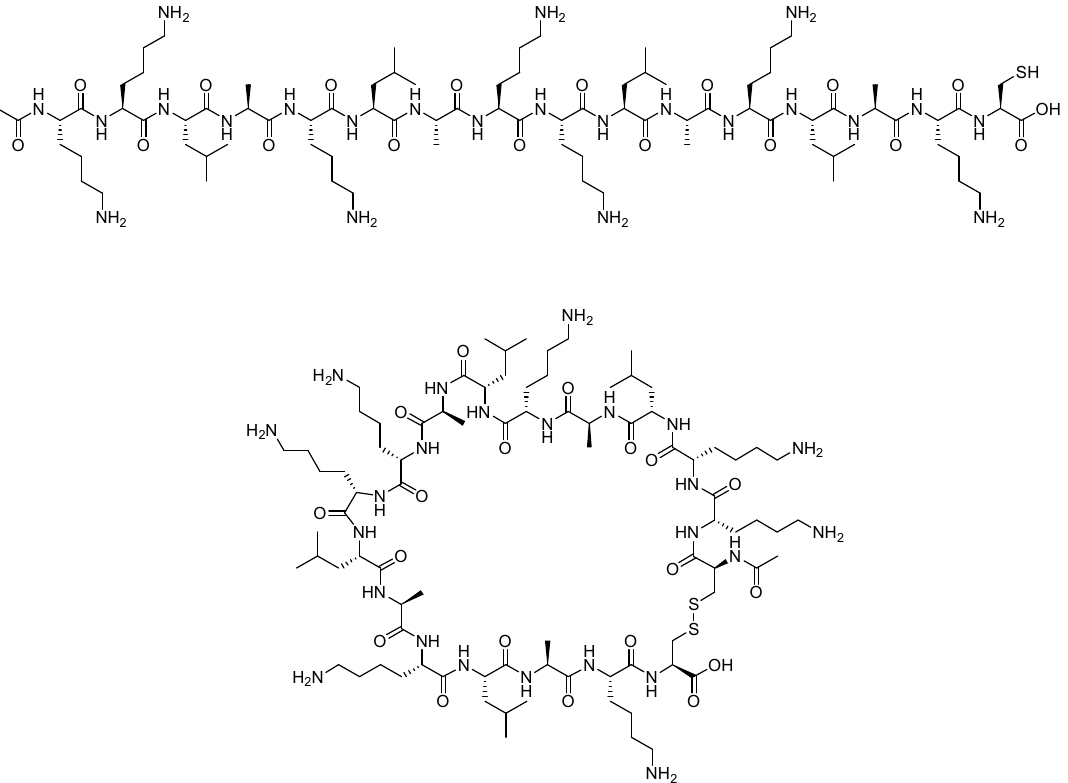
Figure 13. Chemical structure of ( A ) Linear KLA-SS peptide ( B ); Cyclic KLA-SS peptide. Besides the anticancer activity of this peptide, it can also interact electrostatically with the negatively charged phospholipids of the membranes due to the 6 Lys residues within its sequence. Thus, it is also considered as a membrane-active peptide. The hydrophobic interaction between the hydrophobic alkyl chain of the membrane phospholipids and the Leu amino acid stabilizes the α-helical conformation of the peptide [75]. The peptide in its helical form can form pores on the cell membrane and induce cell death. The KLA peptide endocytoses in the cancerous cells was eight times more than in the normal cells. To en- hance the therapeutic efficacy of this peptide, the authors considered the stimuli-respon- sive conformational transformation. Two Cys residues were incorporated at both termini of the peptide to cyclize the peptide via these disulfide bridges (Figure 13B). The cyclized peptide possessed a constrained helicity and hence a lower cytotoxicity. Afterwards, the modified KLA-SS peptide was conjugated with hyaluronic acid (HA) by electrostatic in- teraction, enhancing the endocytosis into the cancer cells that express CD44. The HA is degraded by the upregulated hyaluronidases, the KLA-SS peptide is released into the cy- toplasm of the cancerous cell, and the disulfide bond is reduced by the upregulated GSH into two thiol groups. Finally, the strain that suppresses the helicity is released and the original helicity is restored [75]. According to the helicity data, the authors proved that the reduced KLA-SS peptide has a comparable helicity with the parent KLA peptide (40%), but it was lower in the case of the KLA-SS before the reduction using tris(2-carboxyethyl)phosphine (TCEP) (27%). Furthermore, after electrostatic conjugation with HA, the helicity of KLA-SS/HA was 24% before the reduction and it went up to 30% after the reduction of the disulfide to thiol groups. Liposome leakage experiment also confirmed that the KLA-SS peptide with low helicity (where the experiment was done without GSH) exhibited low capability to disrupt the calcein-loaded lipid membrane. On the other hand, in the presence of GSH, the dis- ruption capability was higher, which confirms the induced reduction of the disulfide bridge by GSH [75]. In conclusion, the cytotoxicity of the KLA peptide could be controlled